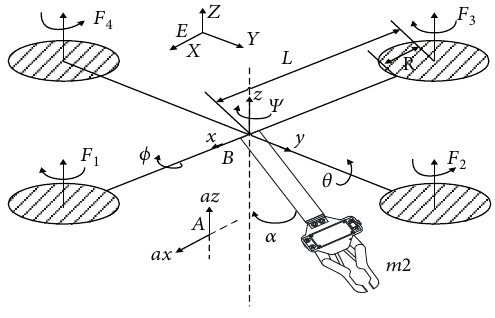
Figure 1: System structure